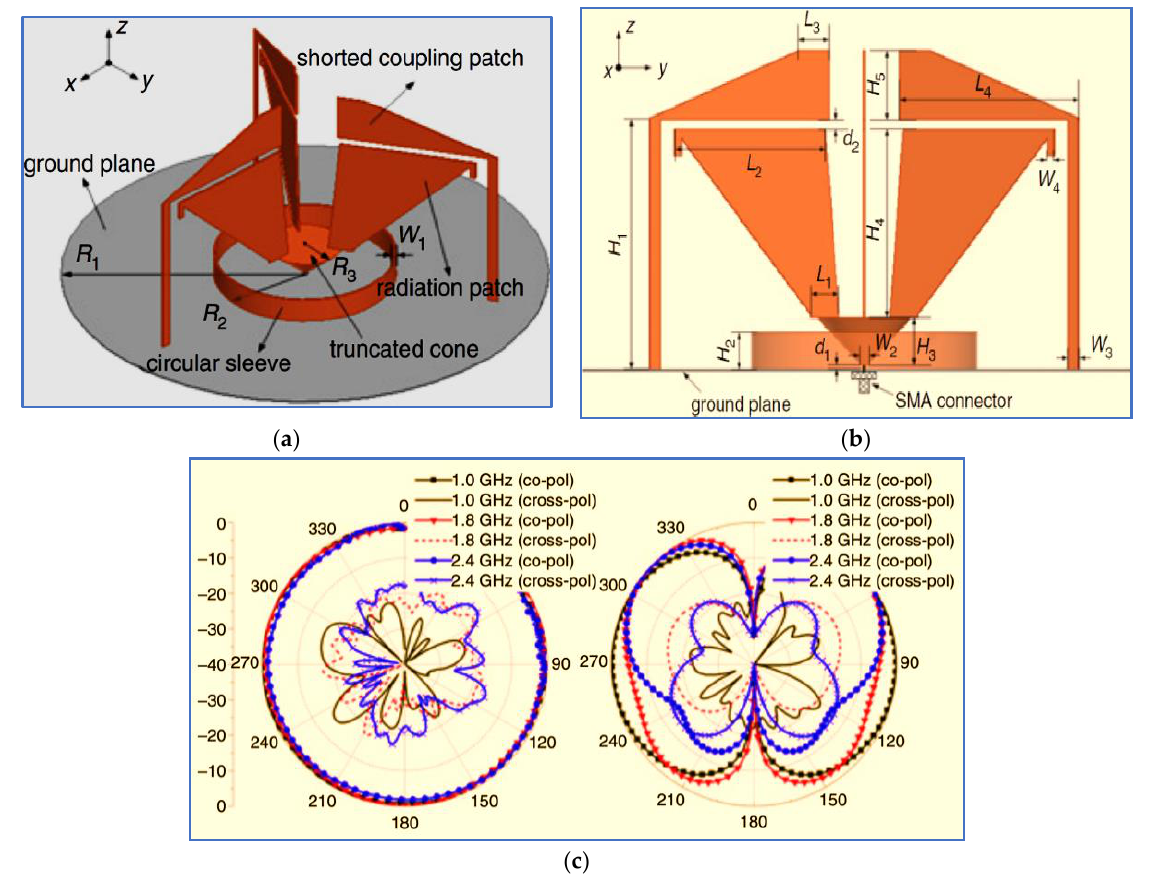
Figure 3. Configuration of an indoor antenna: ( a ) 3D view, ( b ) side view, and ( c ) radiation patterns at 1.5, 1.8 and 2.5 GHz [45]. 1.5, 1.8 and 2.5 GHz